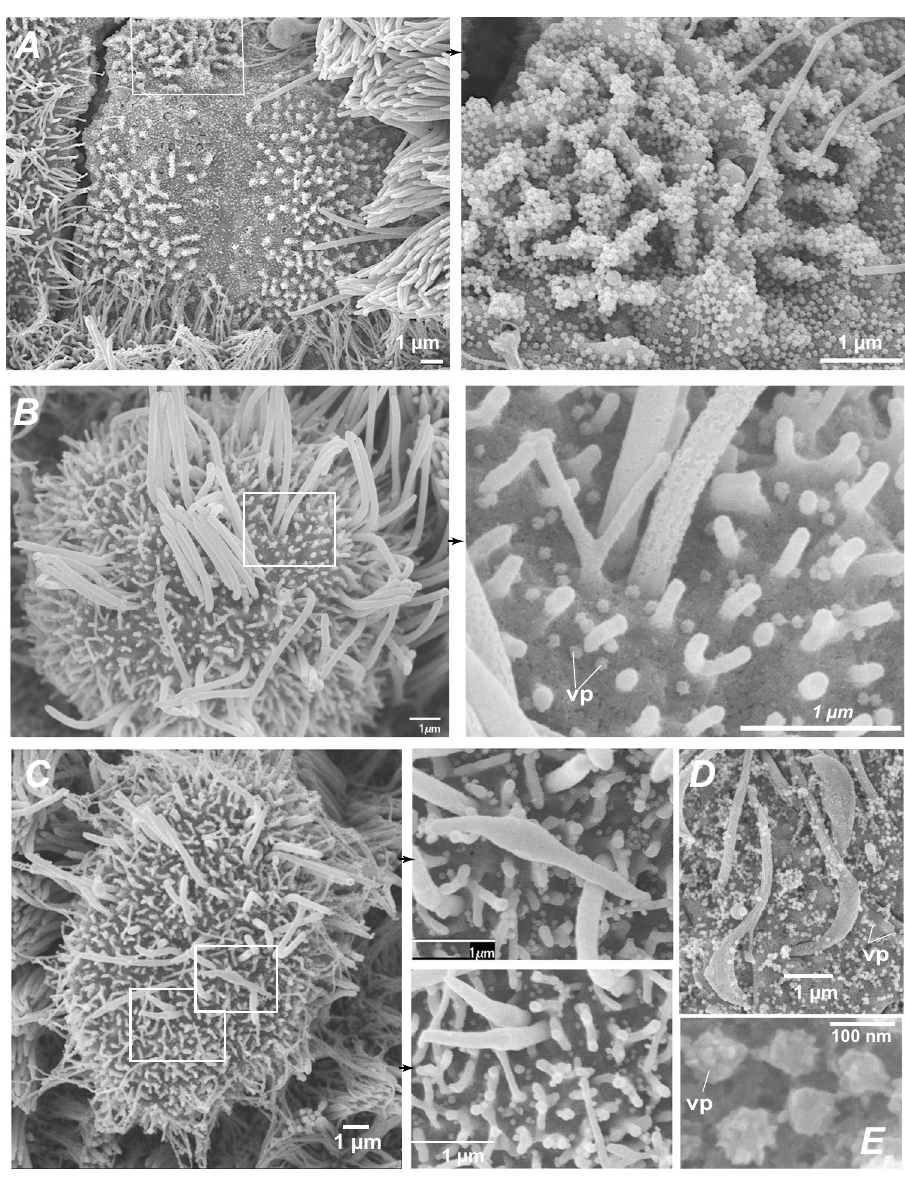
Fig. 3 SARS-CoV-2 infection causes an early loss of motile cilia. A Scanning electron microscopy (SEM) image of a massively infected cell at 2 dpi (left) with a lack of cilia and an accumulation of viral particles at the surface of membrane ruf fl es (enlarged in right panel). B SEM image of an infected cell at 2 dpi with few remaining cilia (left) and scattered viral particles (vp) at the plasma membrane (right). C, D SEM images of infected cells at 2 dpi showing cilia abnormalities, including shortened misshapen cilia ( D left, enlarged in middle panels) and crescent-shaped proximal axonemes ( E ). E SEM image of pleiomorphic SARS-CoV-2 viral